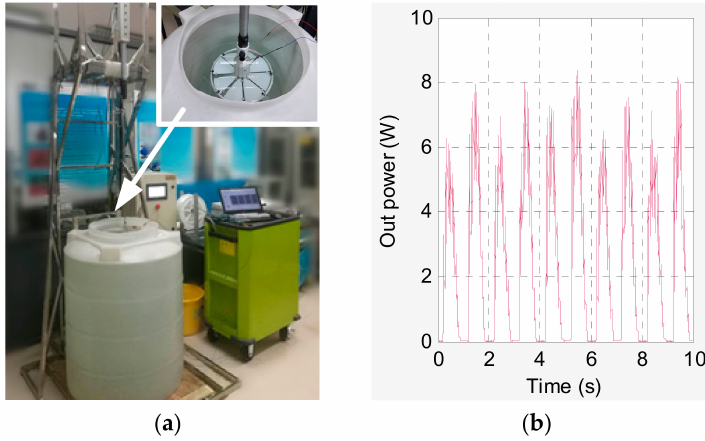
Figure 4. Experiments of rigid blade WEC: ( a ) Experiments; ( b ) Output power curve.